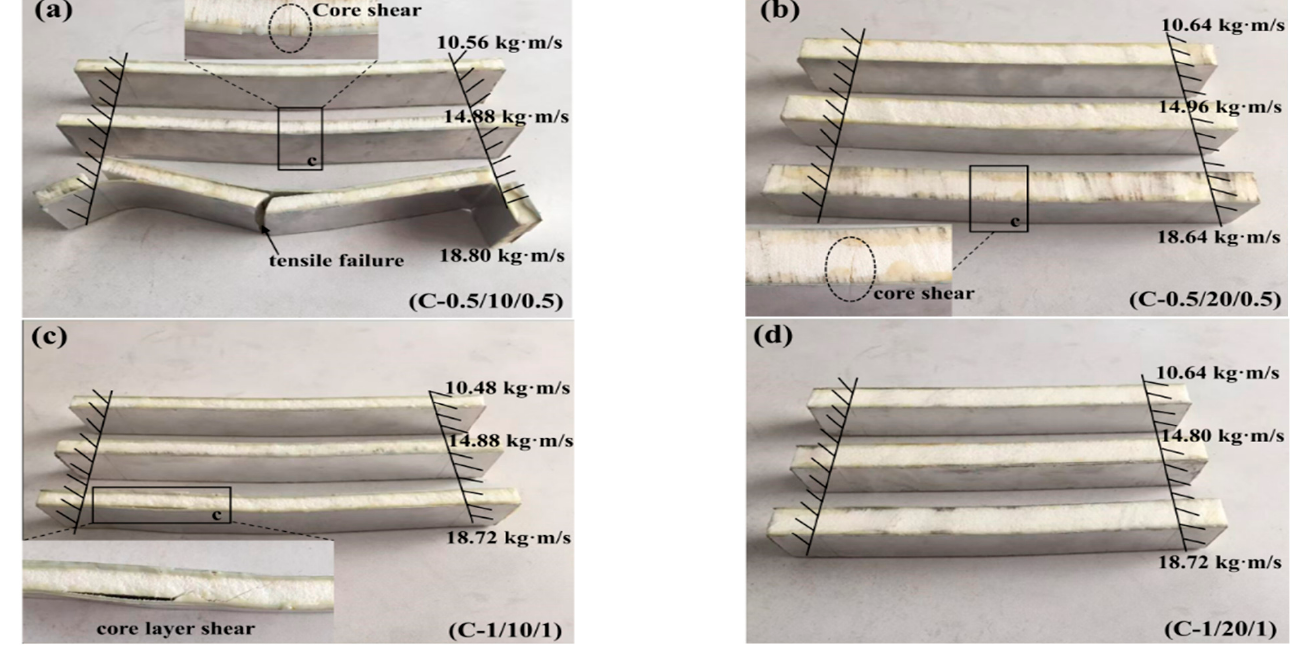
Figure 10. The failure modes of the sandwich beams: ( a ) C-0.5/10/0.5; ( b ) C-0.5/20/0.5; ( c ) C-1.0/10/1.0; ( d ) C-1.0/20/1.0.